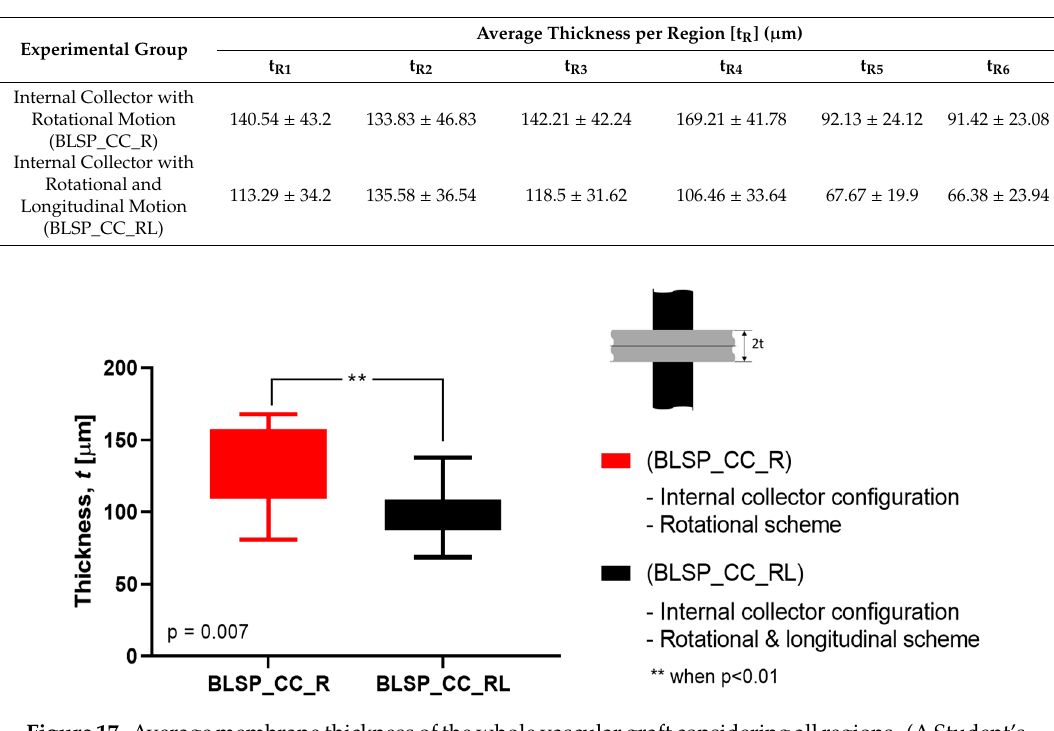
Table 3. Average membrane thickness at di ff erent regions.